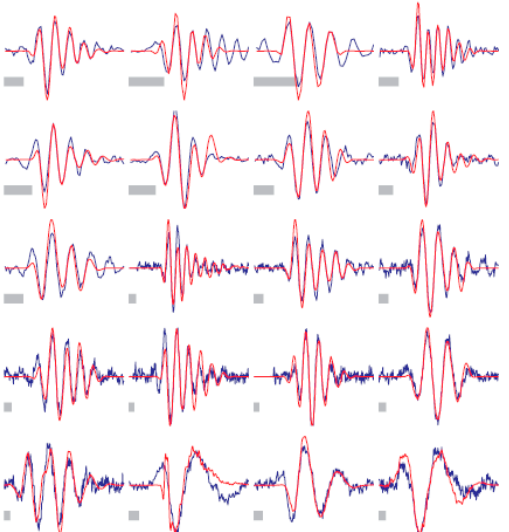
Figure 12. Sparse coding applied to audio. In red 20 basis functions learned from unlabeled audio, in blue the functions from cat auditory nerve fibers [113].